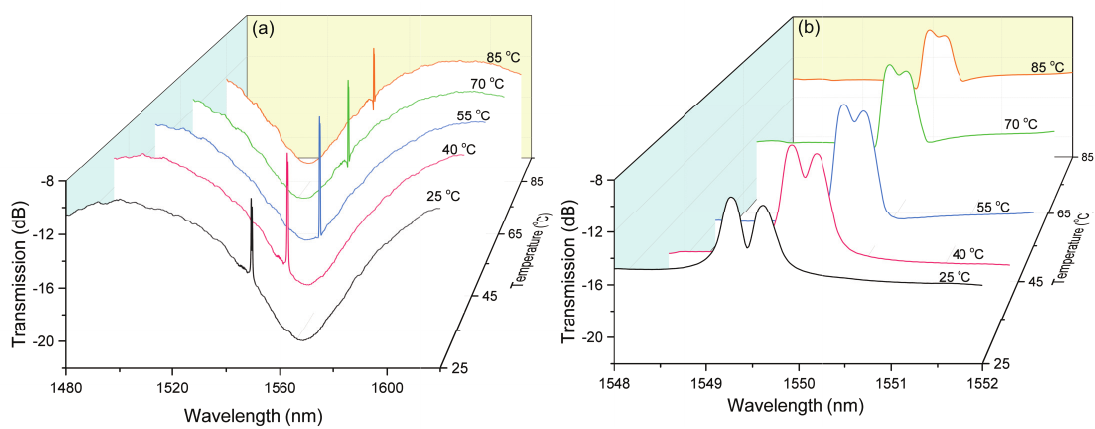
Figure 8. Spectral shifts of Sagnac interference dip ( a ) and Bragg resonant peaks ( b ) with varying temperature.